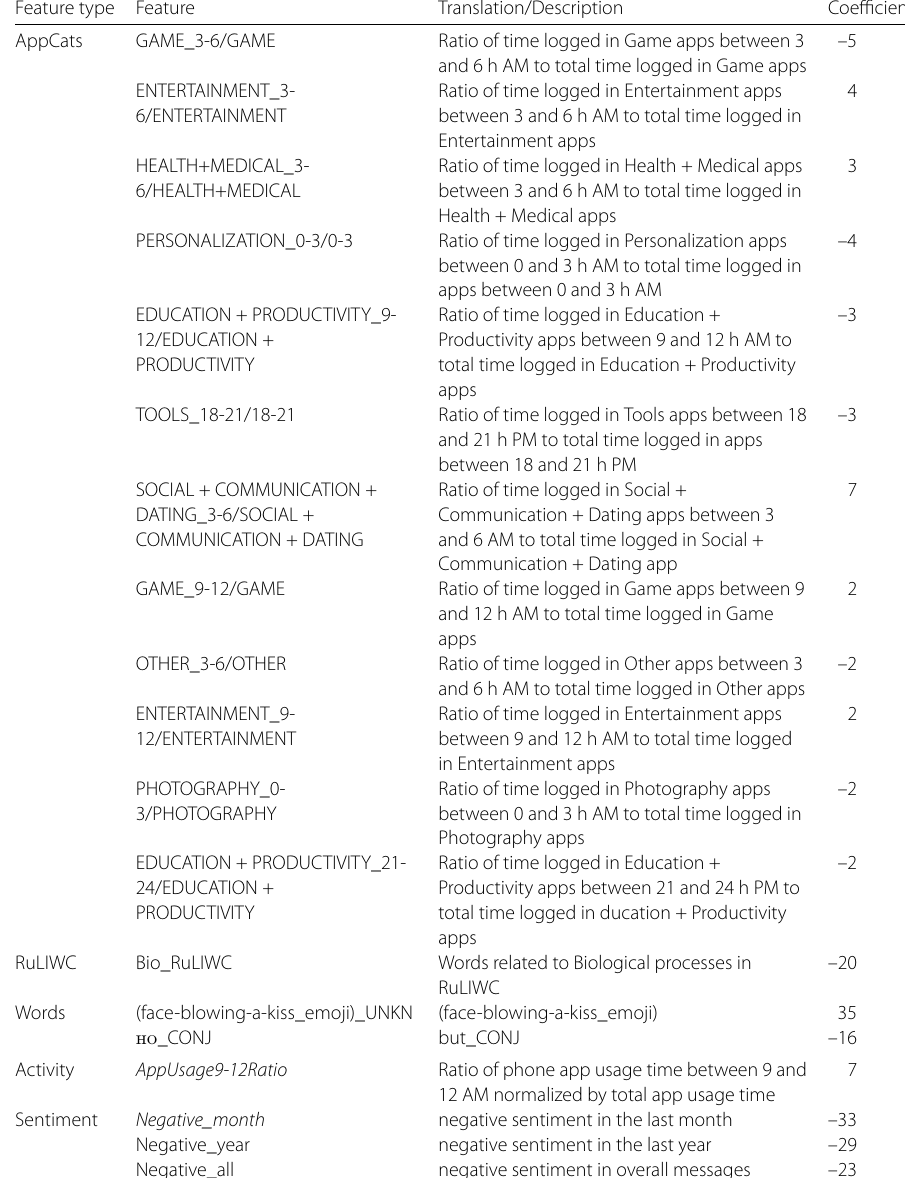
Table 11 Predictive features in WHO-5 scale Feature type